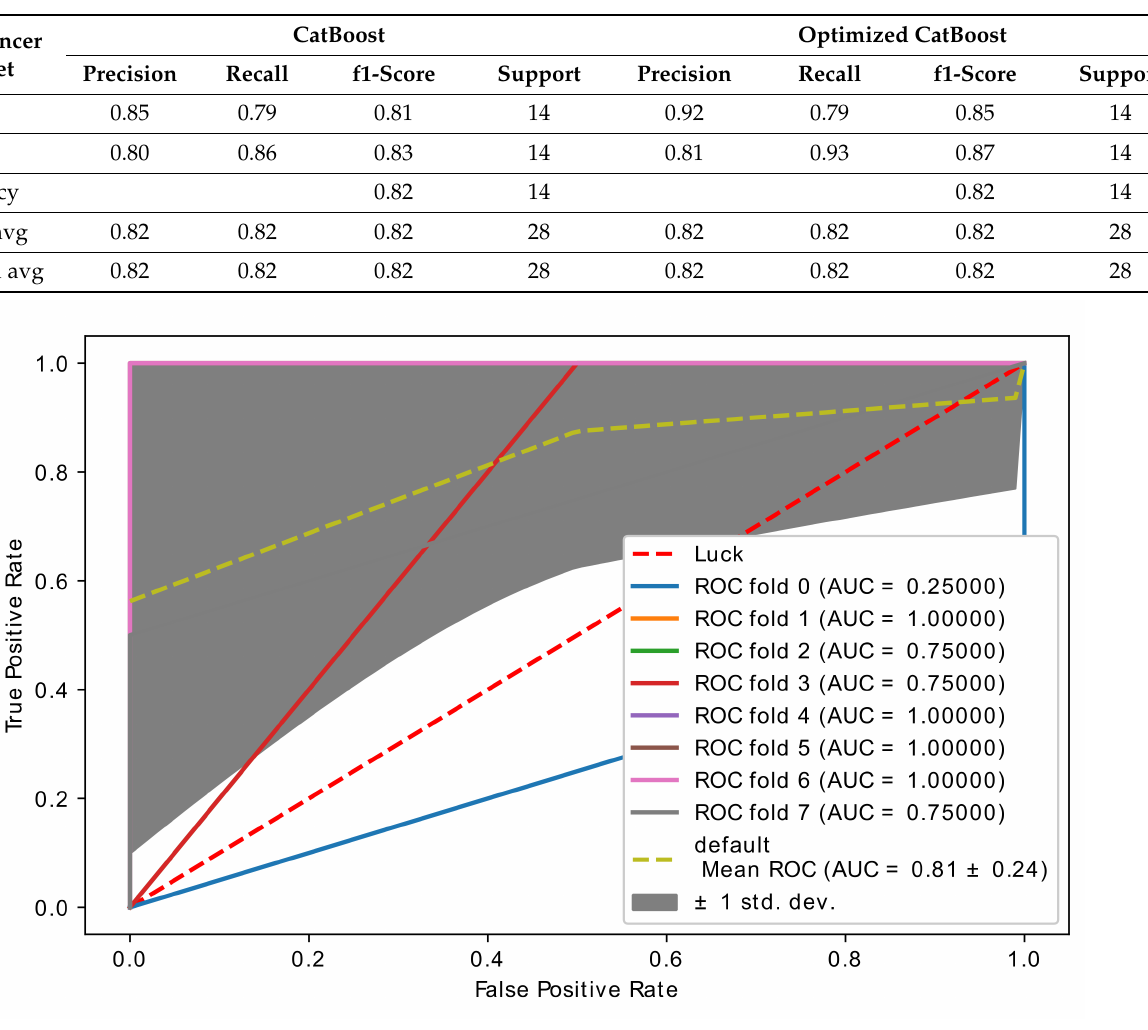
Table 6. Classification report for CatBoost and optimized CatBoost.